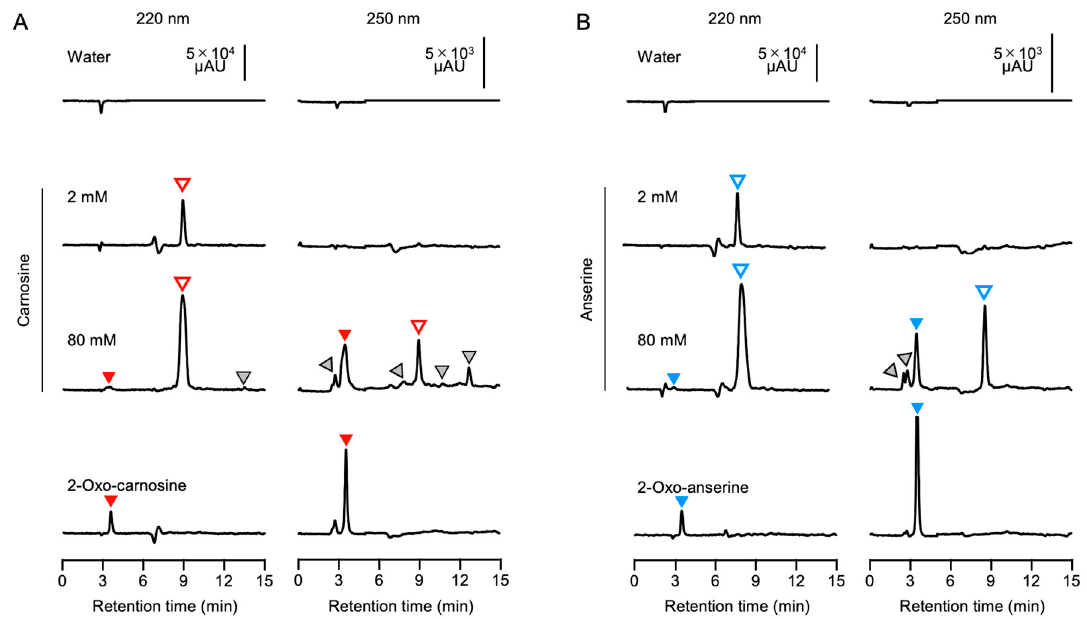
Figure 4. Contaminants including 2-oxo-IDPs in commercial IDPs standards. Different concentrations (2 and 80 mM) of commercial carnosine ( A ) and anserine ( B ) were analyzed by HPLC using an ES-502C 7C column. Representative HPLC chromatograms of the absorbance at 220 nm (left) and 250 nm (right) for the peptide moiety and the 2-oxo-imidazole moiety are indicated. Authentic 2-oxo-carnosine and 2-oxo-anserine (1 mM) were also analyzed by the same approach. Open, filled, and gray triangles indicate IDPs (i.e., carnosine and anserine), 2-oxo-IDPs (i.e., 2-oxo-carnosine and 2-oxo-anserine), and unidentified components, respectively.